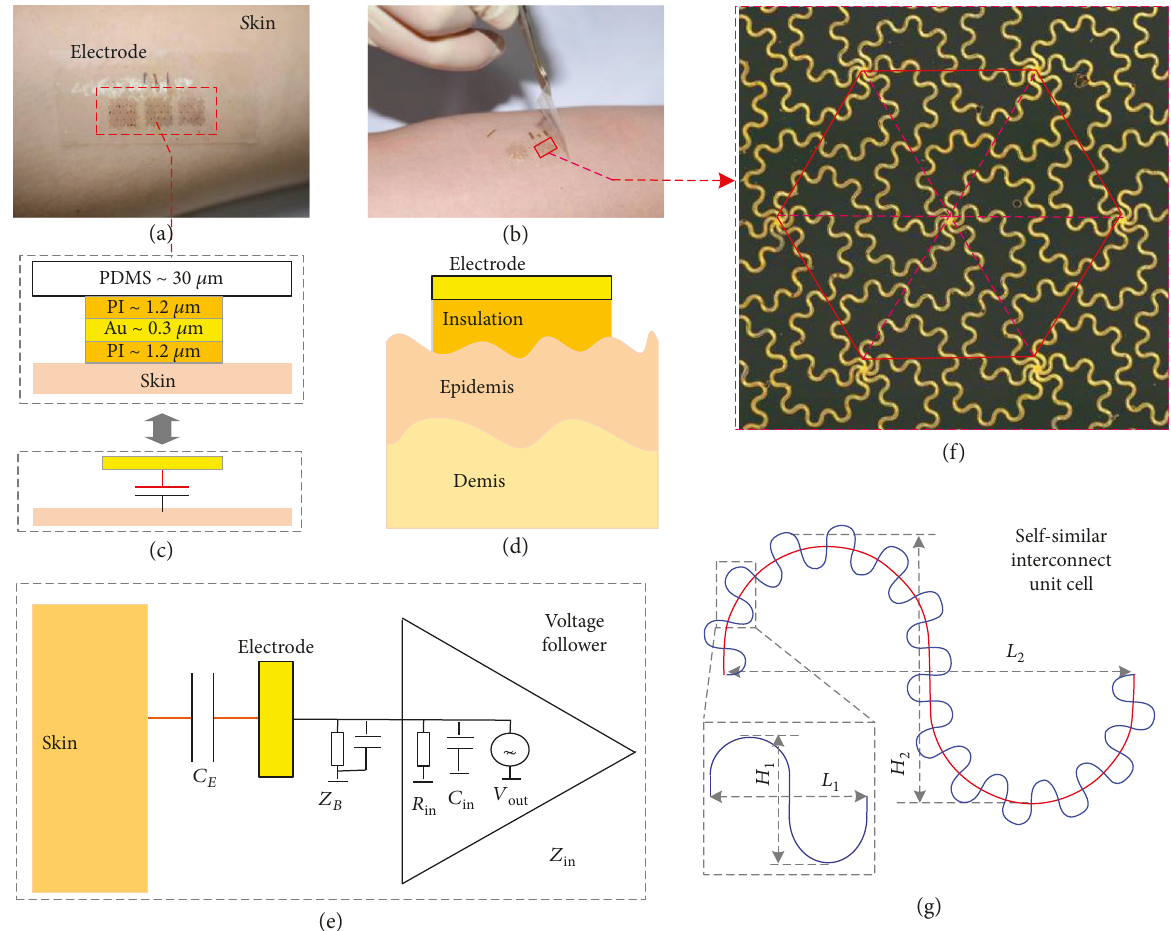
Figure 1: Self-similar inspired surface electrode: (a) the electrode laminated on the skin surface conformally; (b) the electrode delaminated from the skin surface; (c) and (d) schematic graph of the skin-electrode interface via capacitive coupling; (e) data acquisition circuit for the electrode with a voltage follower; (f) network-shaped electrode with the second-order serpentine structure; and (g) geometry parameters of the microstructure with the 1st- and 2nd-order serpentine